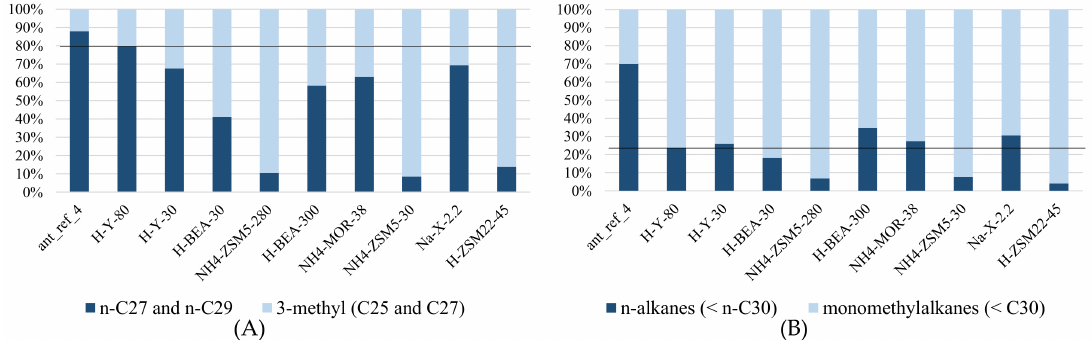
Figure 5. The relative quantities recovered from the n-hexane extracts of the zeolite samples exposed to M. pharaonis foragers: ( A ) n-heptacosane (n-C 27 ) and n-nonacosane (C 29 ) versus 3-methylpentacosane (3-MeC 25 ) and 3-methylheptacosane (3-MeC 27 ); and ( B ) all n-alkanes smaller than n-triacontane (n-C 30 ) versus all monomethylalkanes with backbones smaller than triacontane (<C 30 ). For both ( A , B ), the distributions of the two groups in the reference sample (H-Y-80) are shown by the black